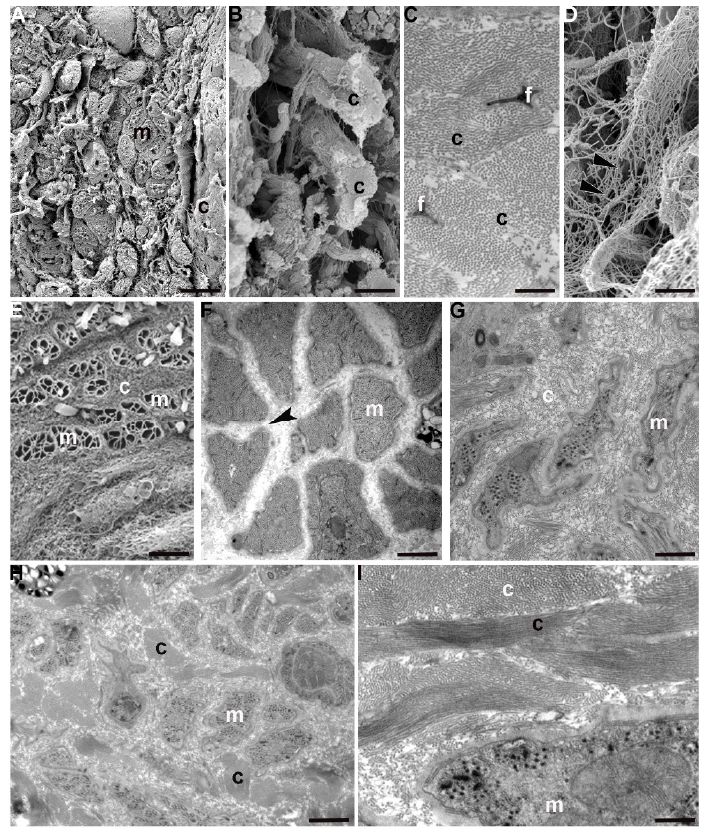
Figure 3. Juvenile H. verbana (50 days from hatching) in cross section. Scanning (SEM) and transmission (TEM) electron microscopy. SEM ( A , B , D , E ) and TEM ( C , F – I ) analysis of cross sectioned leech. Under the epithelium, muscle fibres (m) embedded in a structured ECM characterized by bundles of fibrillar collagen (c) are visible ( A ). ( B ) Detail of the collagenic scaffold. Collagen fibrils are regularly arranged in parallel to form bundles (c). ( C ) TEM micrograph of cross-sectioned collagenic bundles. Each bundle is made of fibrils that are hexagonally arranged and tightly packed. Fibroblast tapered tips (f), showing membrane expansions (giving to the cells a stellate shape), embrace collagen fibrils (c). ( D ) ECM close to the cells show a loose fibrillar network. ( E ) In the proximity of the body surface, large amounts of collagenic scaffold (c) and well developed and grouped muscle fibres (m) are visible. Muscle fibres are very small in size and due to the peculiar SEM preparation, only their membranes are evidenced (m). ( F ) TEM micrograph of differentiated muscle fibres (m) showing the contractile material organized in sarcomeres. In each group, muscle fibres are characterized by complementary adjacent surfaces (black arrowhead). An ECM with loose properties is interposed among fibres. ( G , H ) Detail of the innermost part of cross sectioned body. Bundles of collagen (c), arranged radially, delimits the corridors occupied by an ECM with loose properties in which small migrating myocytes (m), less differentiated in respect to the external ones, are visible. ( I ) Detail of myocytes in the migrating phenotype (m) showing the exiguous number of myosin and actin filaments. Scale bars: ( E ) 15 μm ; ( A ) 6 μm ; ( D ) 3.2 μm ; ( B ) 2.2 μm ; ( F ) 700 nm; ( H ) 600 nm; ( G ) 500 nm; ( C , I ) 300 nm.